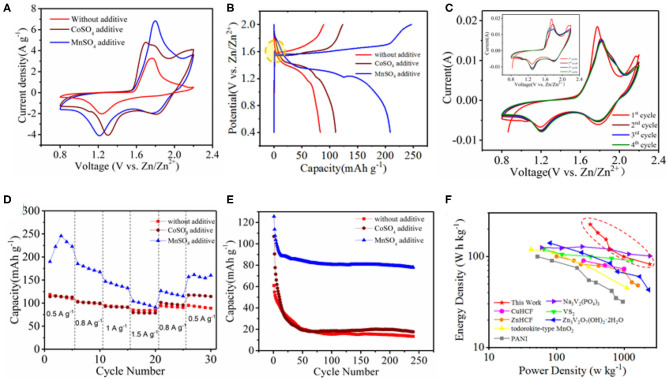
Electrochemical performance of Co3O4@MnO2 in 2 M ZnSO4 electrolyte and with CoSO4 or MnSO4 additive. (A) CV curves. (B) GCD curves. (C) The first four CV cycles in MnSO4 contained electrolyte, and within CoSO4 contained electrolyte (inset). (D) Rate performance at different current densities from 0.5 to 1.5 A g−1. (E) Cycling performance of Co3O4@MnO2 at 3 A g−1. (F) Ragone plots of Zn ion battery and results from literature.